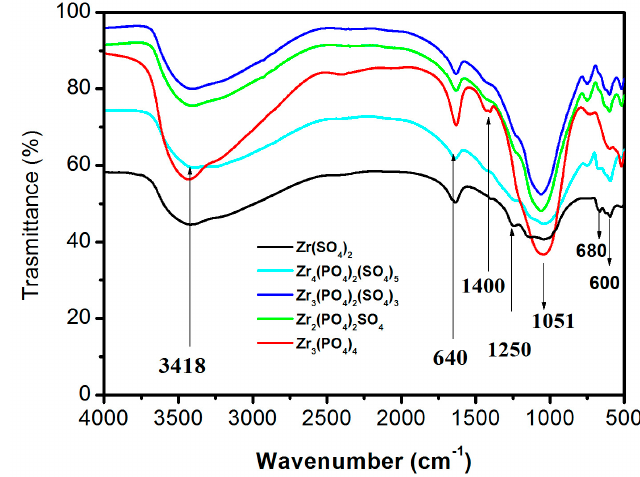
Figure 4. FT-IR spectra of the zirconium phosphate–sulphate catalysts.